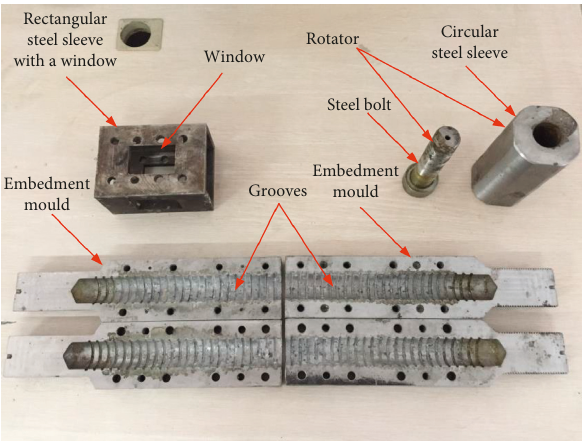
Figure 1: Main components of the DEPT